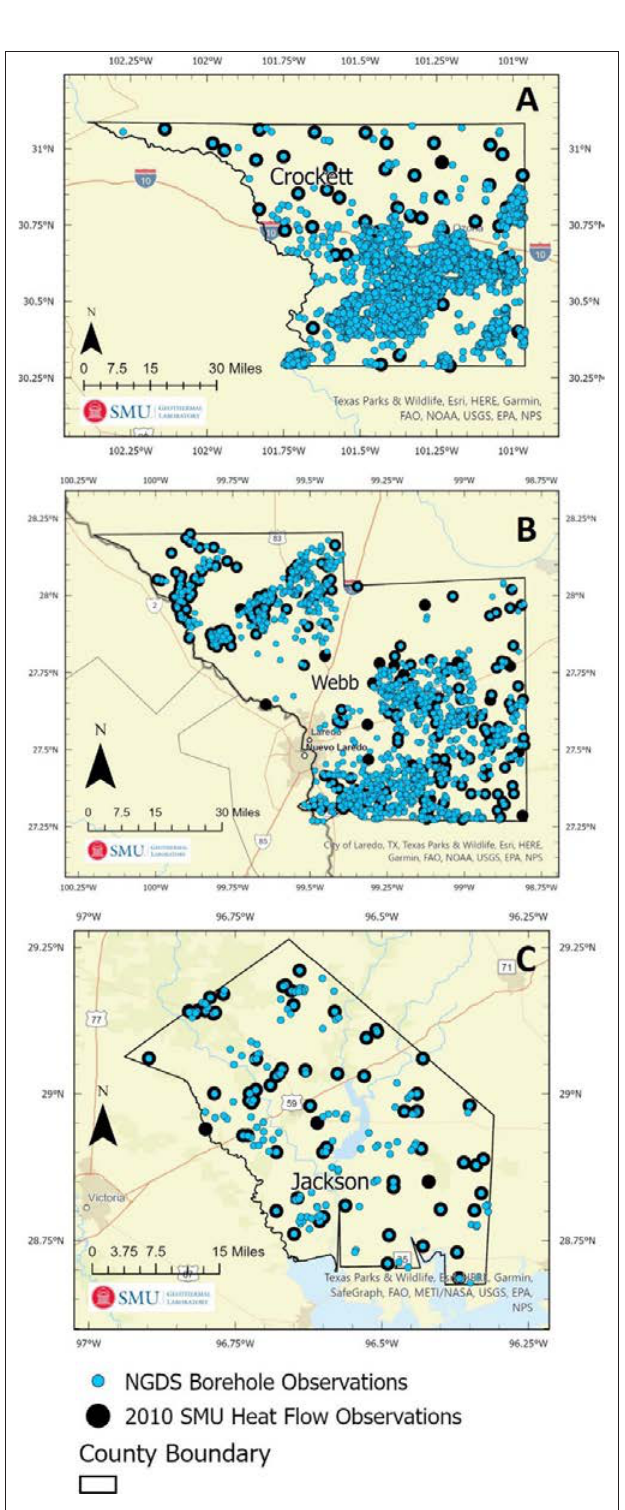
Figure 4. Temperature site data density maps for Crockett, Webb, and Jackson counties. The black circles represent Southern Methodist University heat flow data from Blackwell et al. (2011a, b, c), and the blue circles represent the updated temperatures from the National Geothermal Data System (NGDS 2020 ) borehole observation file ( NGDS 2014), for a combined total of 5,410 well